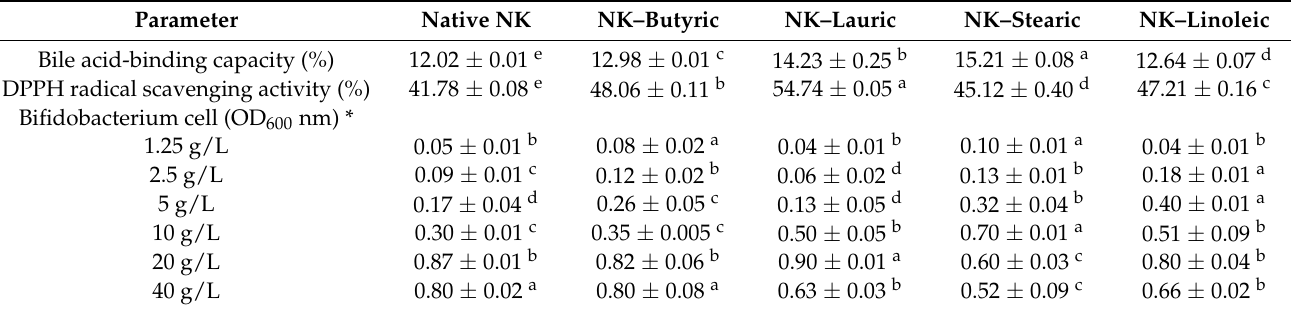
Table 3. In vitro bile acid binding capacity, free radical scavenging activity, and Bifidobacterium cell stimulation of native Noui Khuea (NK) starch and NK starch–lipid complexes with varying fatty acid chain